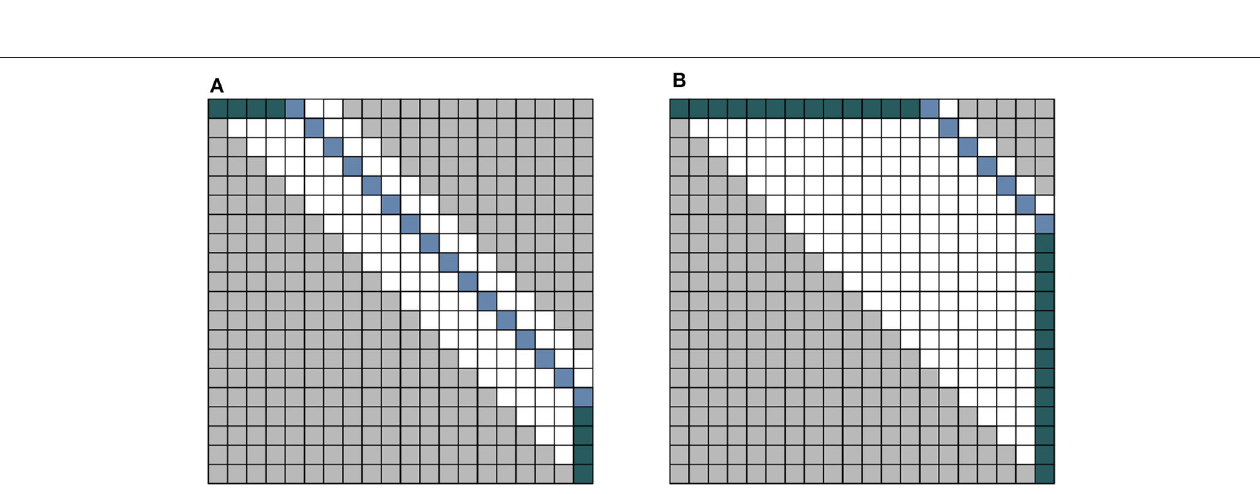
FIGURE 6 | Overview of the warping measure. (A) Displays the two time-series O and M that are compared for alignment. However, the warping algorithm is adapted with a new window w that prevents comparing values of M with values of O that lie in the future, as seen in (B) . (C) Shows the alignment from (B) from which the measure is determined. Notice that there is no alignment from M to points in O that lie in the relative future of M .